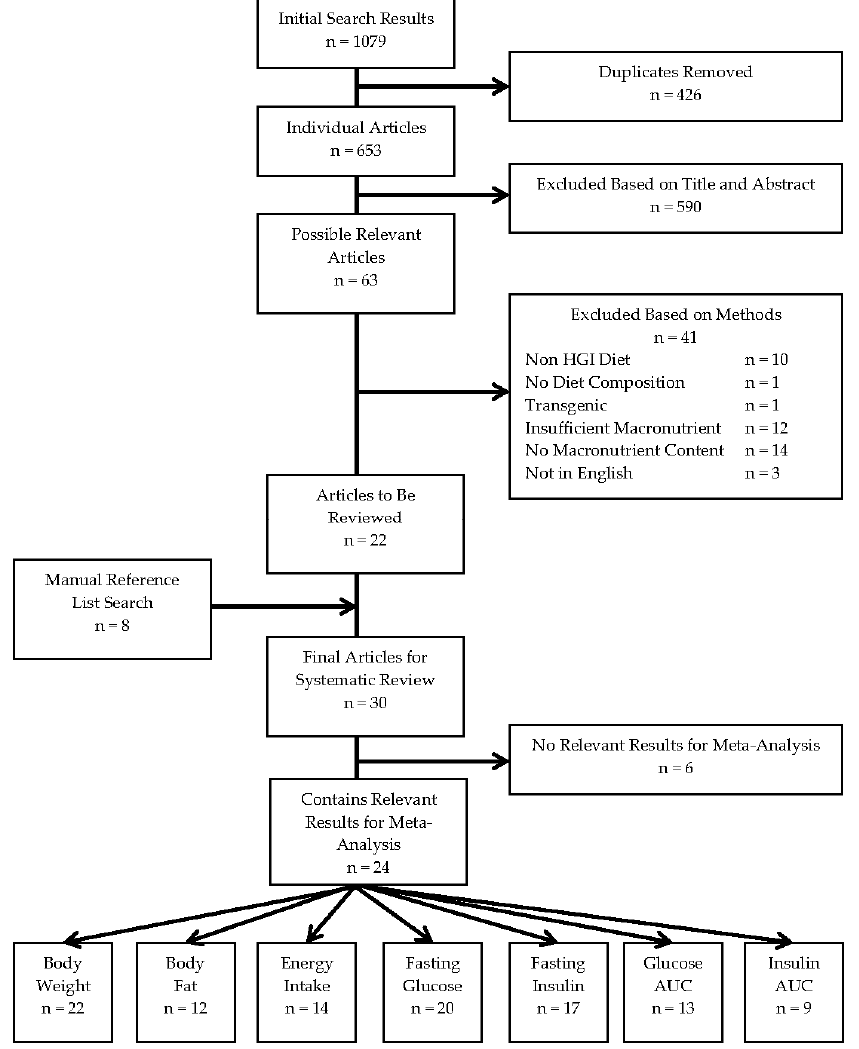
Figure 1. Flow of the study selection process for this systematic review. A flow diagram of article numbers included and excluded at each step of the systematic review process. Adapted from Ainge et al. 2011 [13]. n , number of articles; HGI, high glycaemic index; AUC, area under the curve.